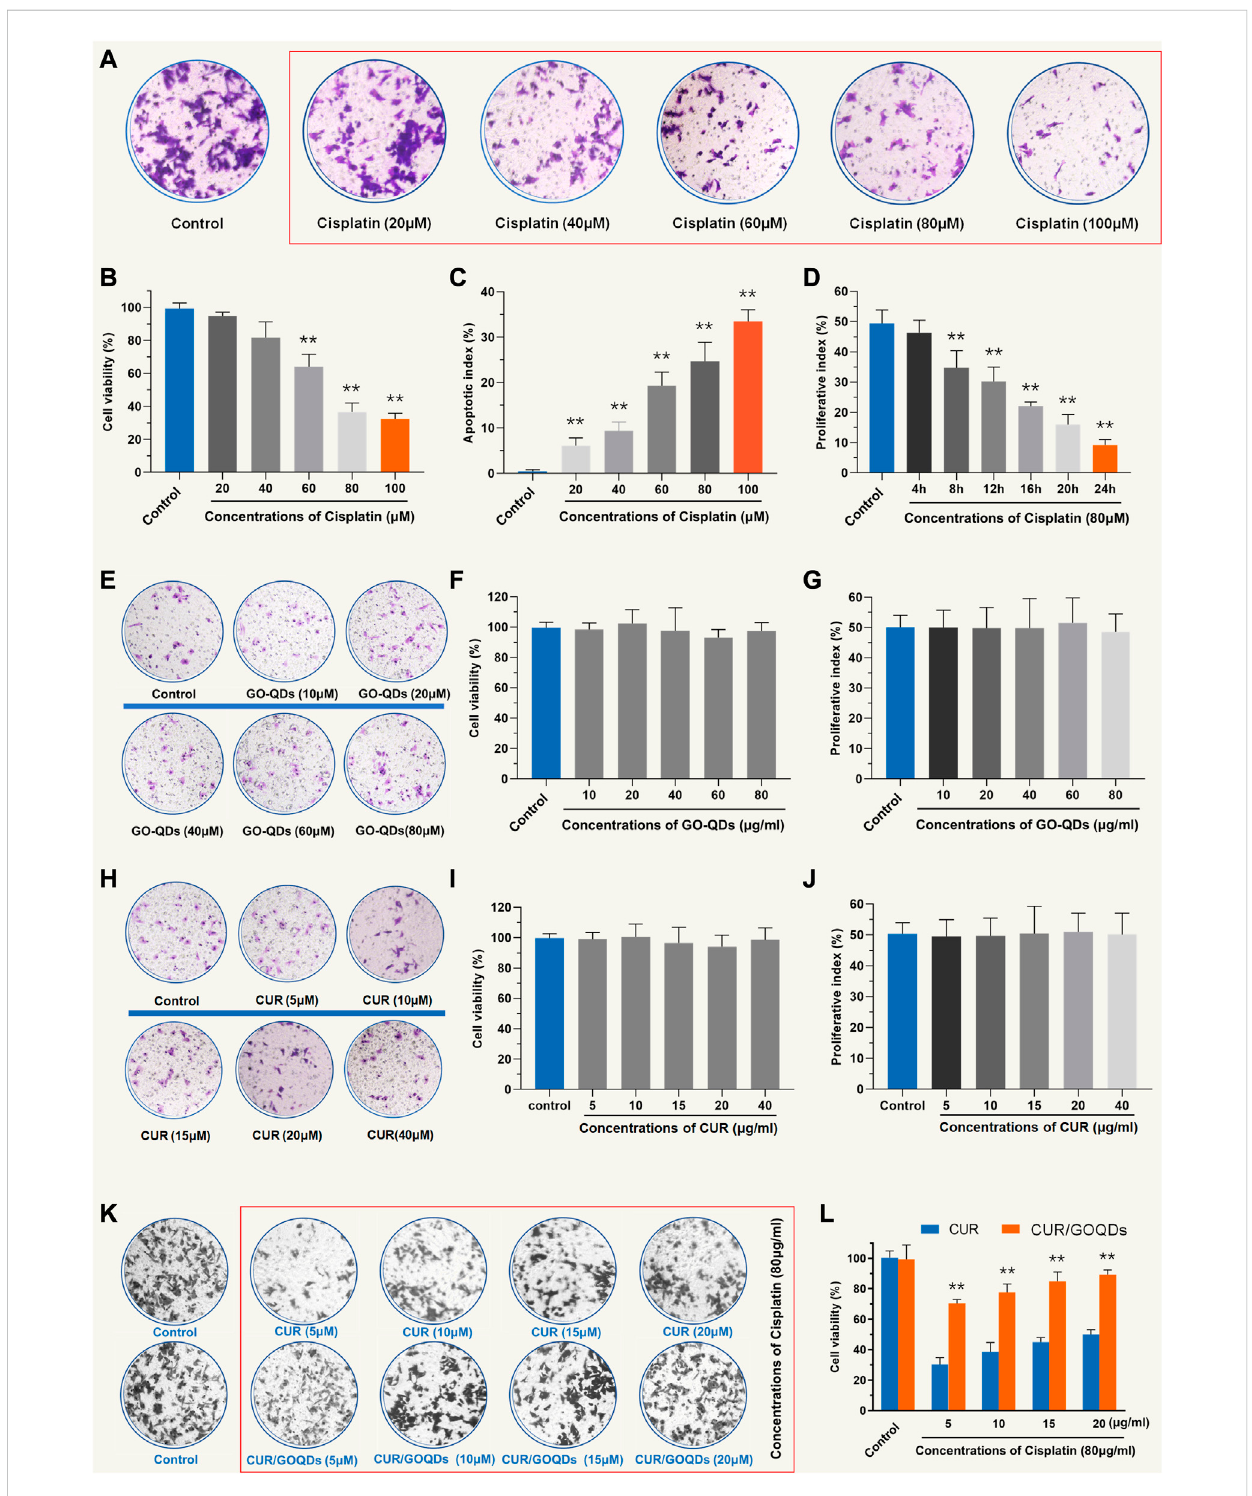
FIGURE 2 Cellviability ofOC1pretreatedwith CURand CUR/GOQDs againstCIS-inducedcelldamage. (A – C) CellviabilityofOC1cellstreatedwith arange of concentrations of CIS (20, 40, 60, 80, and 100 μ M) for 24 h. (D) Survival rate of OC1 cells under 80 μ M CIS at different incubation times (4, 8, 12, 16, 20, and 24 h). (E – G) The activity of OC1 cells treated with drug-free GOQDs. (H – J) In the experiment, additional cell viability tests were conducted for different concentrations of CUR. (K – L) Cell viability of OC1 cells before pretreatment with CUR or CUR/GOQDs (5, 10, 15, and 20 μ g/mL) followed by treatment with 80 μ M CIS for 24 h ** p < 0.01 as compared to the control